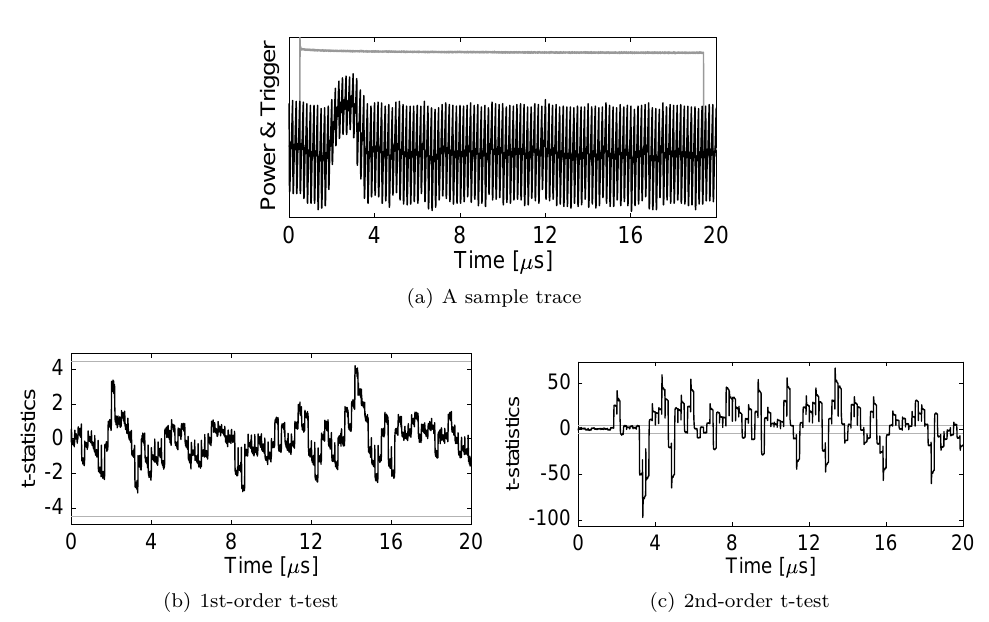
Figure 9: FPGA-based fixed versus random t-test using 100 million traces, Skinny-64-64 round-based encryption, first-order GHPC ANF pipeline.